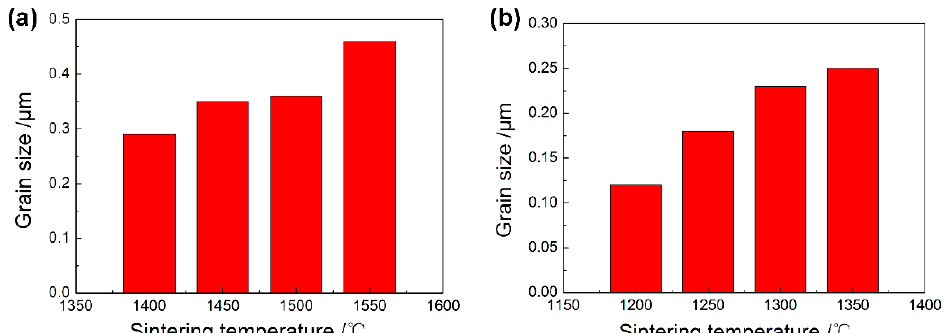
Figure 10. Grain sizes of the ZrO 2 samples with the milled using different powders sintered at different temperatures: ( a ) 200 nm, ( b ) 100 nm.